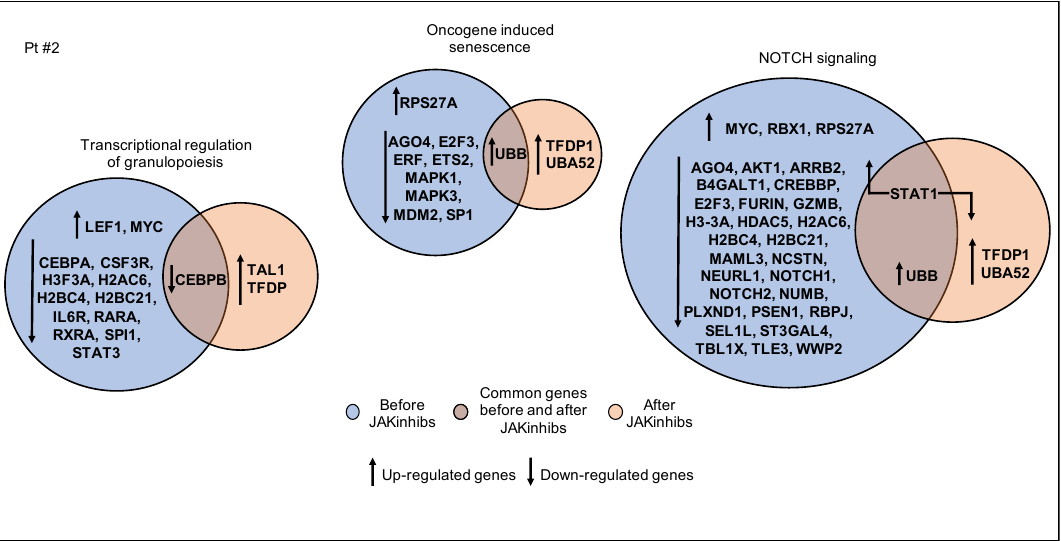
Figure 4. Pathway enrichment analysis before and after JAKinhibs treatment. Pt, patient.